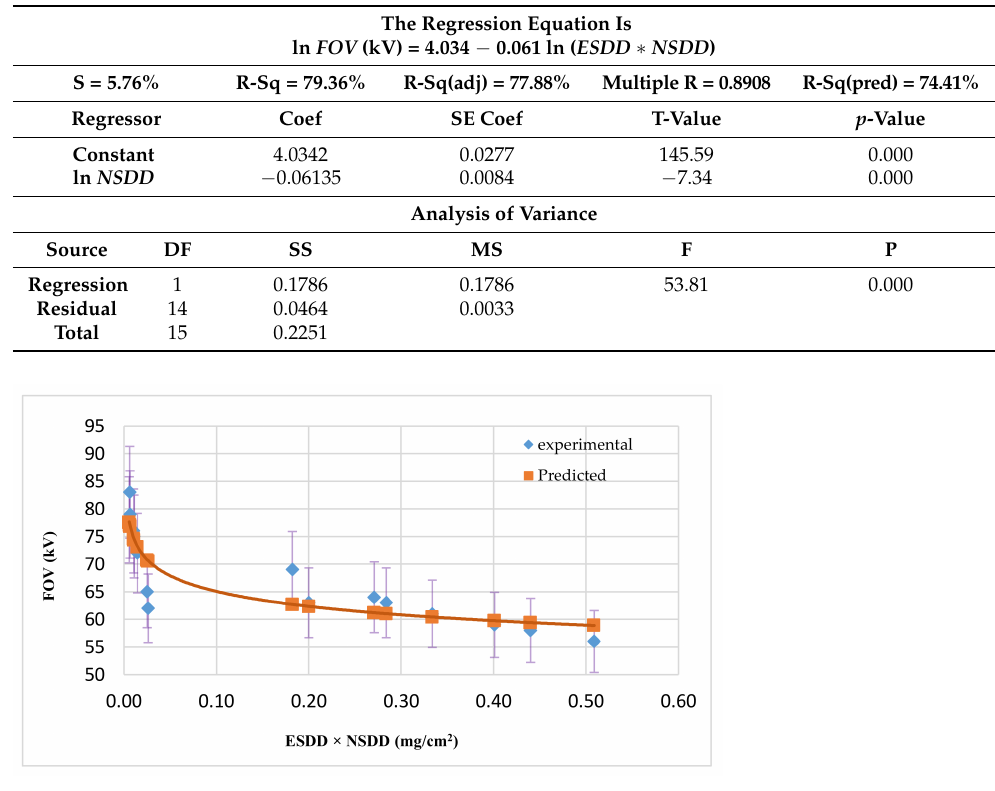
Figure 7. ESDD & NSDD product based FOV model curve for predicted and experimental